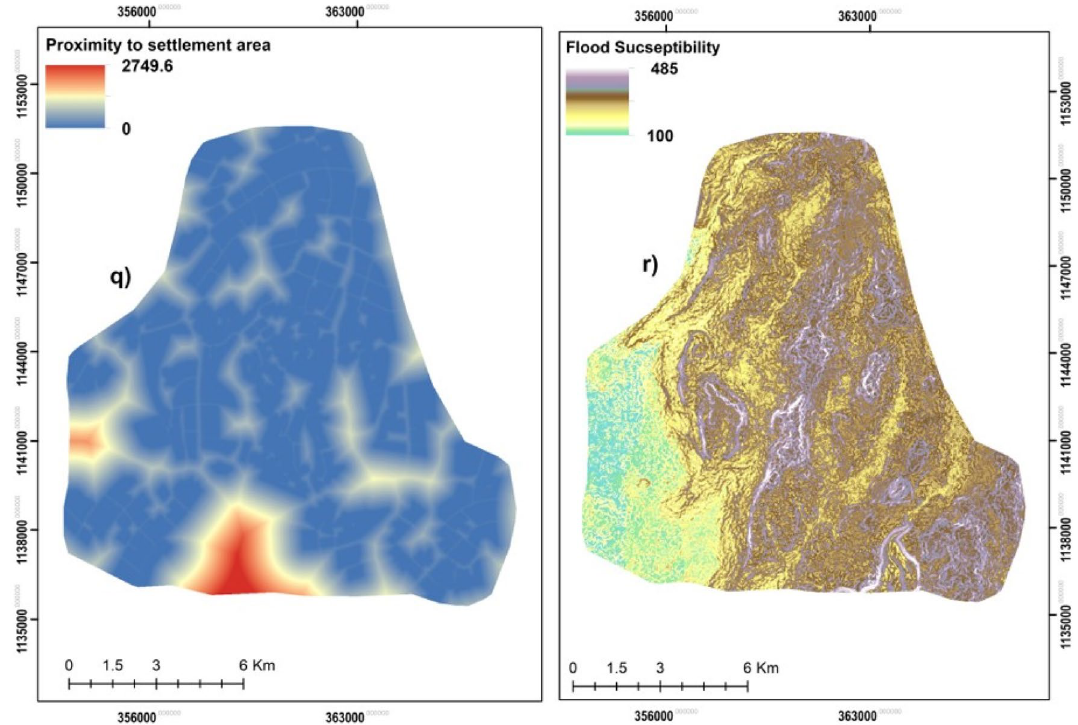
Fig. 7 q proximity to settlement r flood susceptibility